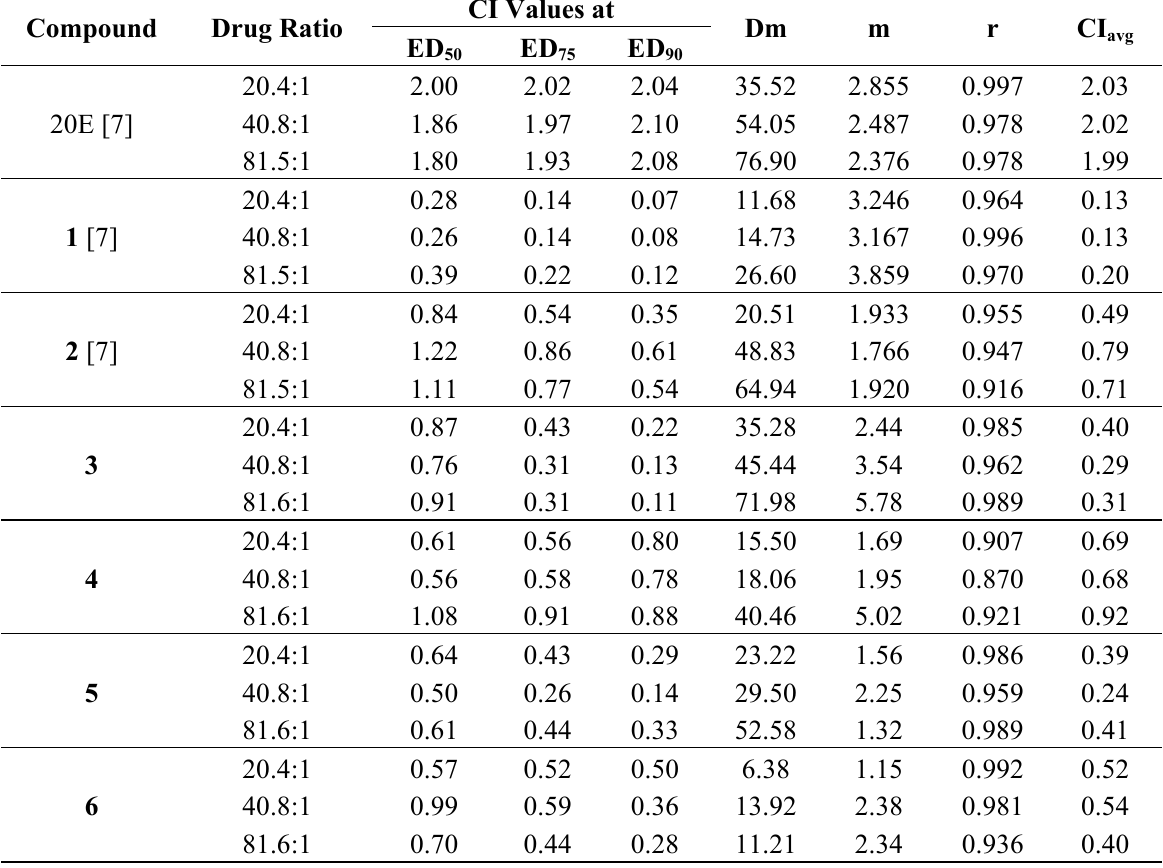
, ED and ED 50 75 90